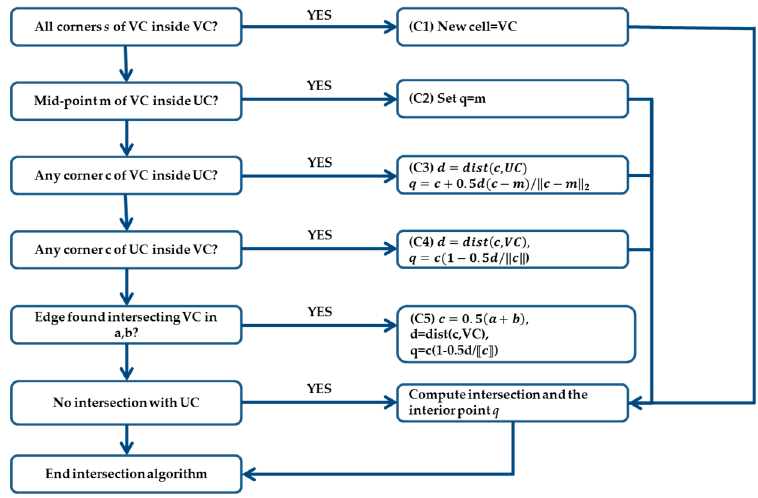
Figure 7. Algorithm for intersecting a Voronoi cell (VC) and the unit cell (UC).